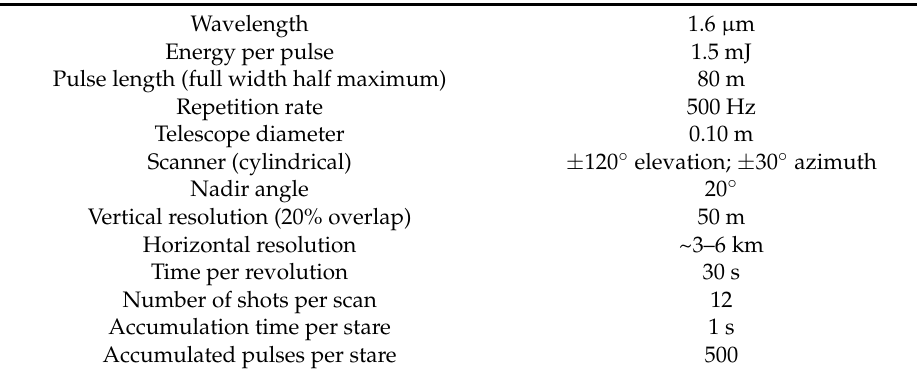
Table 1. Main attributes of the lidar